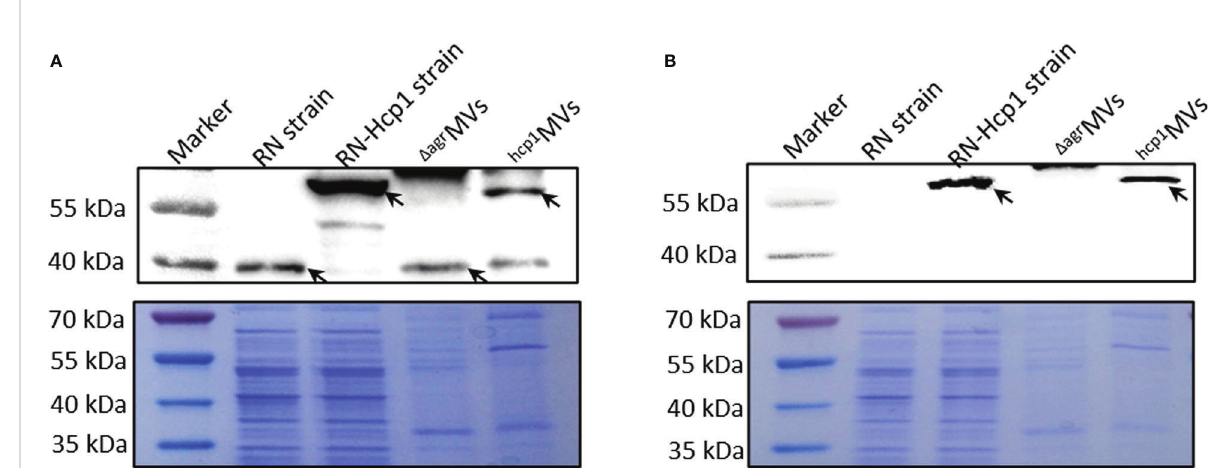
FIGURE 1 Characterization of PdhB-Hcp1 fusion proteins in S. aureus RN-Hcp1 strain and its MVs. Western blot with anti-PdhB (A) and anti-Hcp1 (B) antibodies, respectively. The top panels showed the blots of target proteins (indicated by black arrows) in bacterial cell lysates of S. aureus RN and RN-Hcp1 strains and their MVs, including D agr MVs and hcp1 MVs. The proteins in samples of interest were separated by 12% SDS-PAGE, stained with Coomassie blue R- 250 and served as loading controls (bottom panels). The sizes of the protein Marker were indicated on the